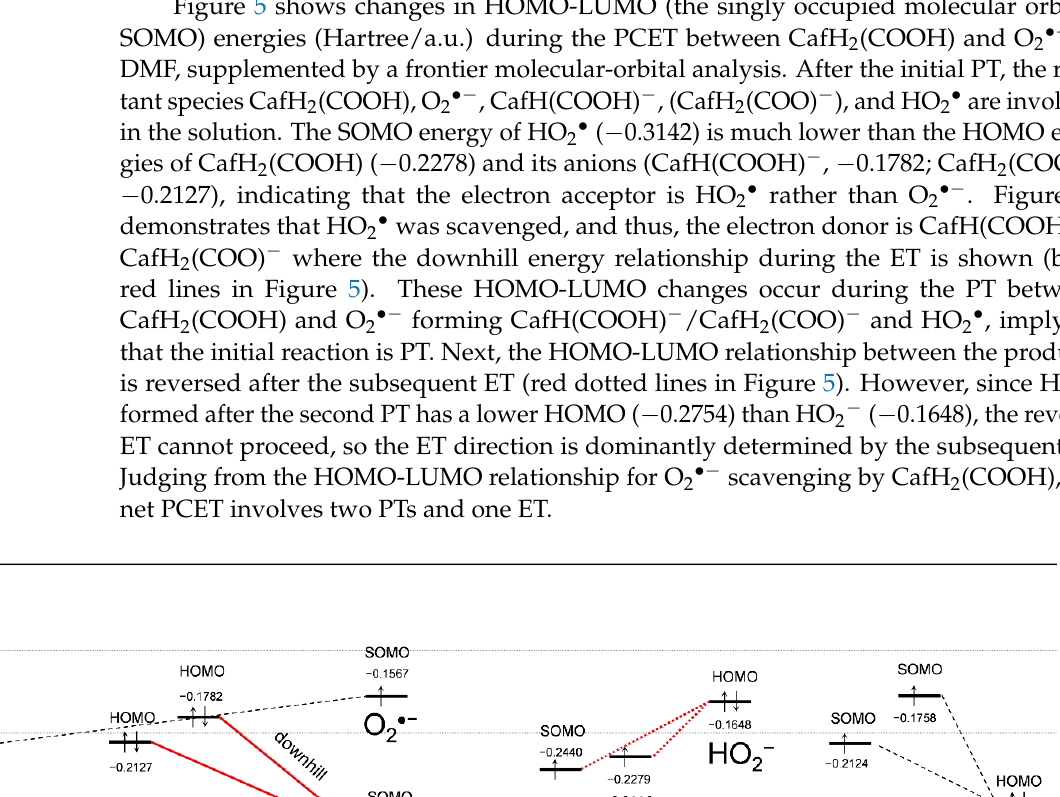
charges distributed on the three OH protons of CafH 2 (COOH) are also indicated.